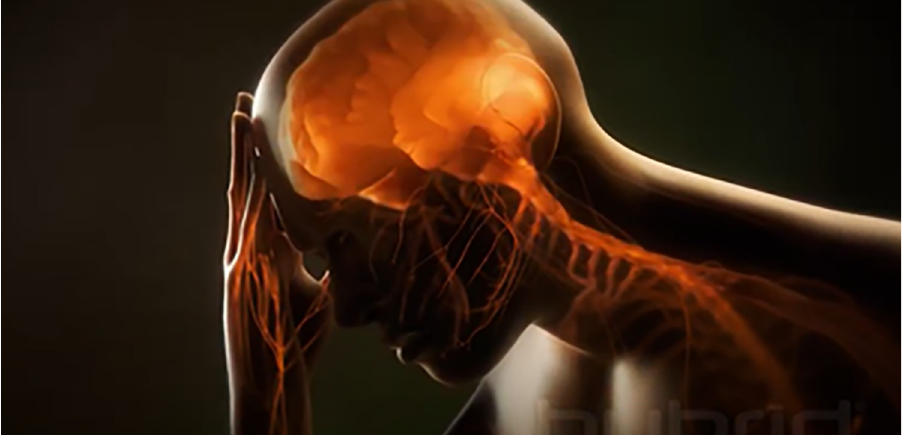
Fig 2. Screenshot of the ‘sham’ VR scenario. Reproduced with permission from Hybrid